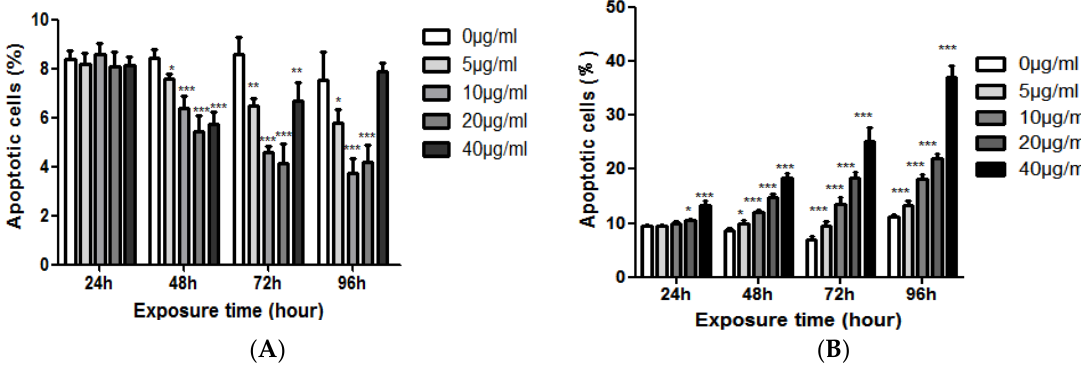
Figure 5. The effects of EGCG dose on apoptotic cells (%) of NCM460 ( A ) and COLO205 ( B ) cells. Significant differences between EGCG-treated groups and controls at each treatment interval are indicated by * p < 0.05, ** p < 0.01, and *** p < 0.001.